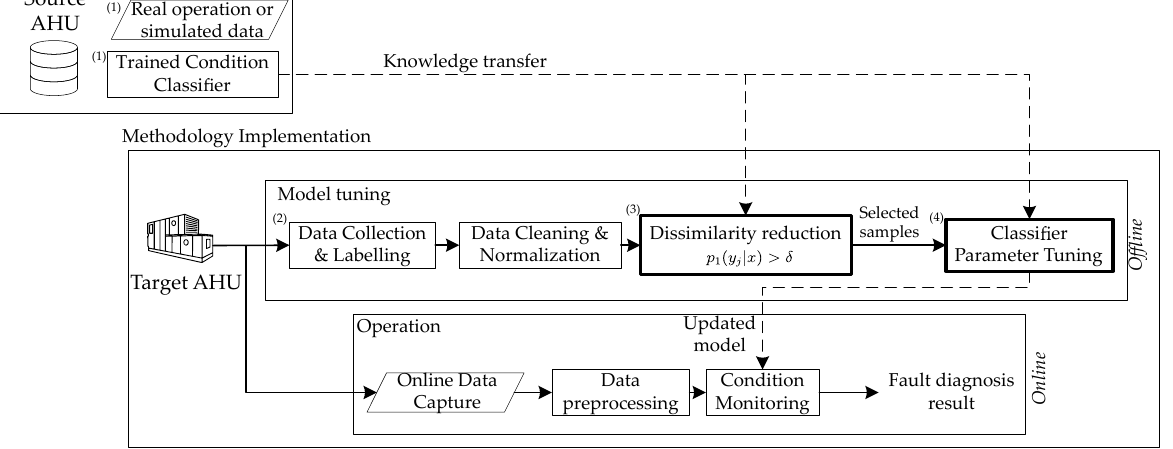
Figure 1. Overview of the proposed methodology. The initial source AHU training dataset consists of labelled samples for all the classes and the target AHU dataset typically consists of fewer labelled samples that are used to tune the initial